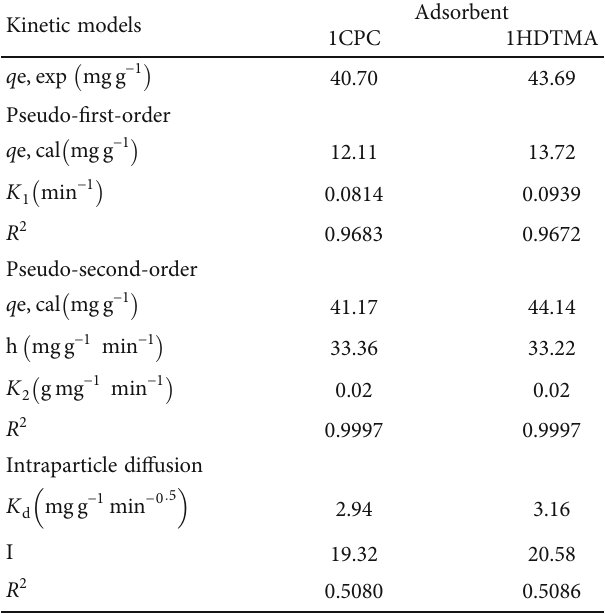
Table 2: Parameters of the kinetic adsorption analysis. Kinetic